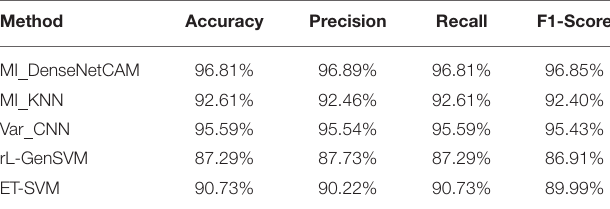
TABLE 2 | The experimental results of five